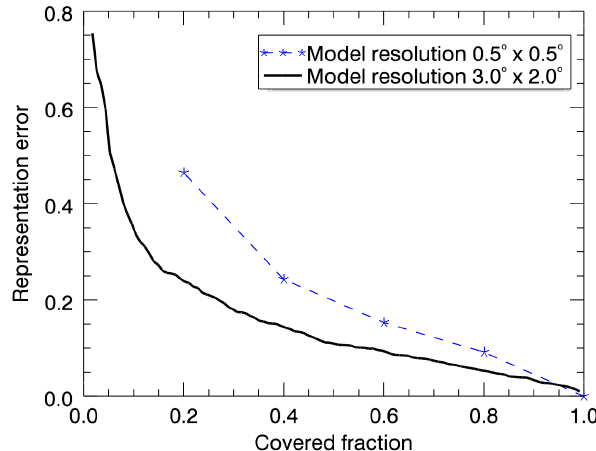
Figure 1. Relative horizontal representativeness errors as a func- tion of the covered fraction of one model grid cell in the case of OMI tropospheric NO 2 columns for polluted area(s) (mean column 5 × 10 15 moleculescm − 2 ) . The black line indicates the error as a function of the fractional coverage for a 3 ◦ × 2 ◦ grid cell over the area of New York City on 1 day (17 July 2006, 114 OMI pixels). The blue asterisks indicate the mean error as a function of fractional coverage for various 0.5 ◦ × 0.5 ◦ grid cells on 17 July